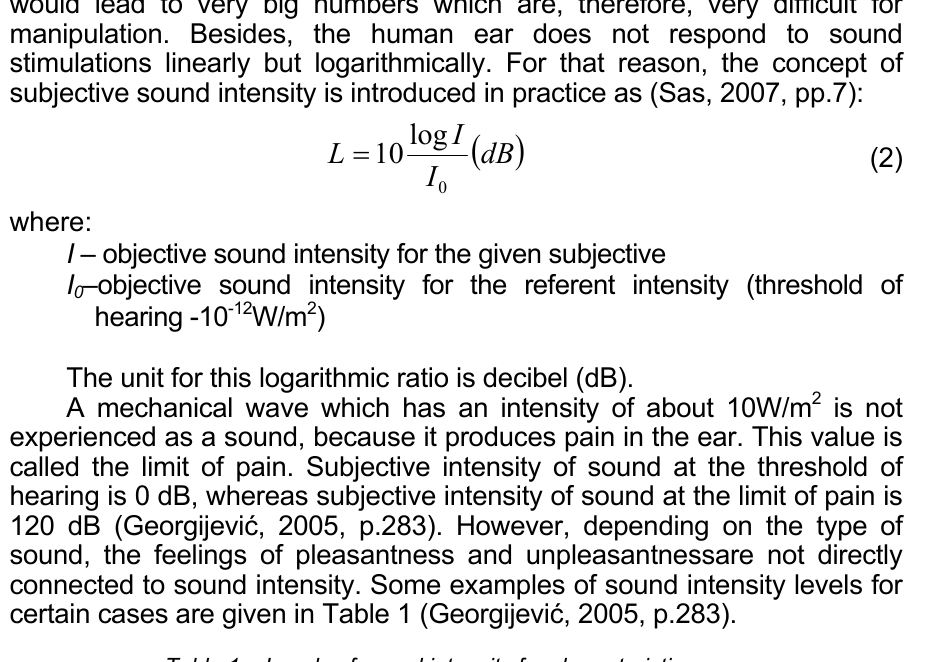
Table 1 – Levels of sound intensity for characteristic cases Таблица 1 – Уровень громкости звука характерных